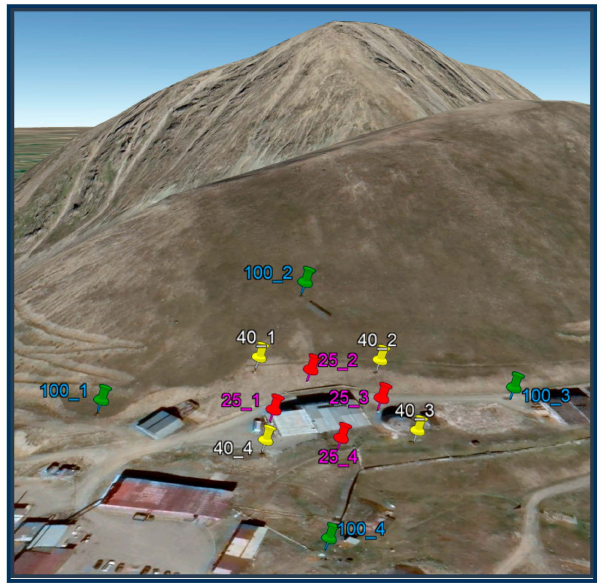
Figure 3. A snapshot of the location of the external storm system of the complex installation